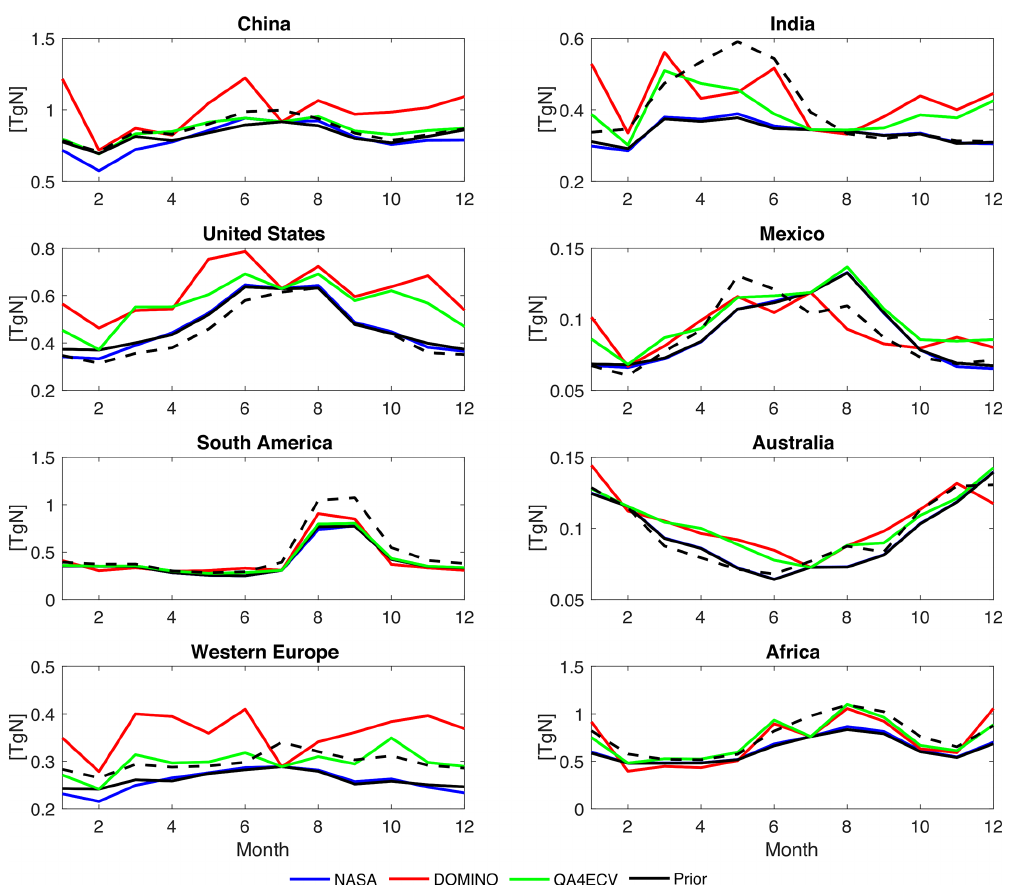
Figure 4. Seasonal variations of total 4D-Var posterior NO x emissions in 2010. The black lines are prior emissions from bottom-up inven- tories (solid lines are from GC-adj; dashed lines are from GCv12). The blue lines are the emissions constrained by the OMI NO 2 NASA product. The red lines are emissions constrained by the OMI NO 2 DOMINO product. The green lines are emissions constrained by the OMI NO 2 QA4ECV